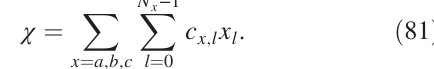
TABLE V. Realization of the model for different values of L , t , and λ in terms of atomic insulators. An atomic insulator is indicated by z x , where x is the Wyckoff position a , b , or c (shown in Fig. 11) and l is the angular momentum. The charge trapped in a disclination Δ Q l and the angular momentum response to the insertion of a flux of m are computed using the expressions Δ Q ¼ n Ω ½ − sgn ð λ Þ L sgn ð t Þ = 2 (cid:3) and Δ s ¼ m ½ 3 sgn t − 2 L sgn λ (cid:3) derived in Sec. III. These results are reproduced by the atomic representation by assigning a z disclination charge of n Ω = 6 and flux angular momentum of m for the atomic insulator in Wyckoff position a (and 0 charge and angular momentum for positions b and c ). The last column indicates the interacting invariant discussed in Sec. VI B. ( L ; sgn ð t Þ ; sgn ð λ Þ z